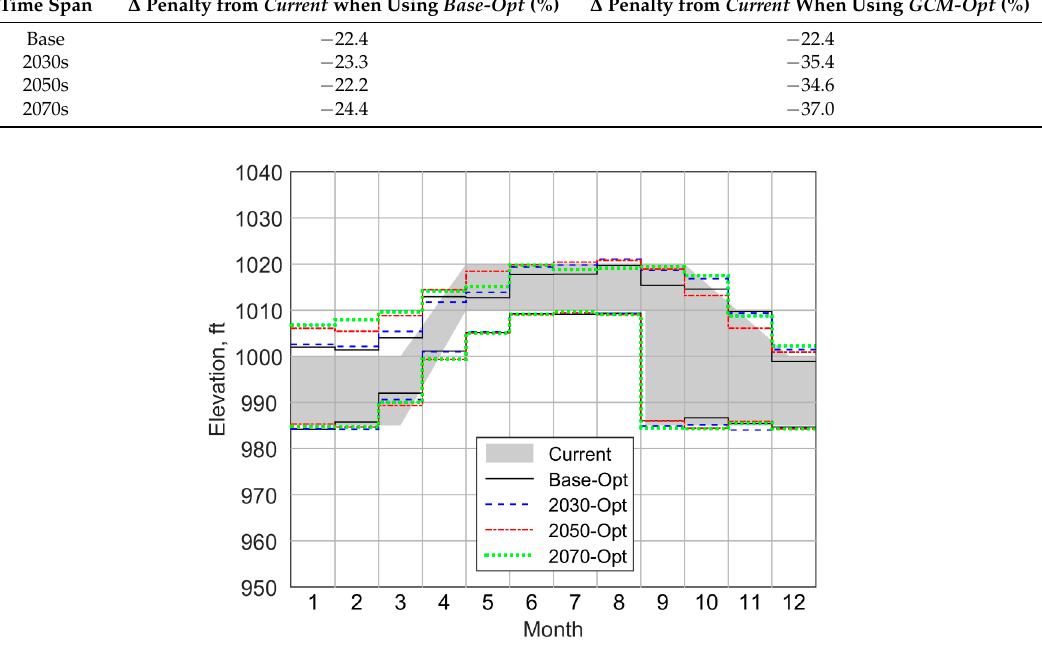
Figure 6. Optimized operating guides compared to the current guide.